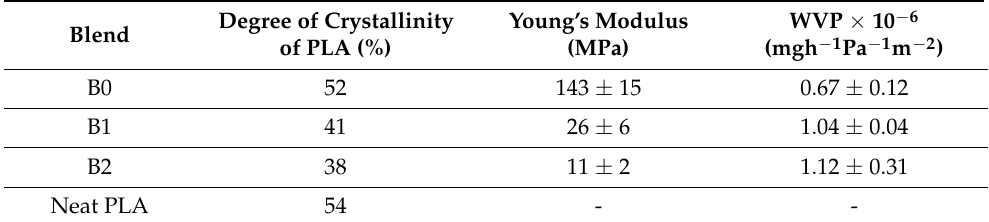
Table 7. The variation of crystallinity of PLA, Young’s modulus and the water vapor permeability in Starch/PLA blend films